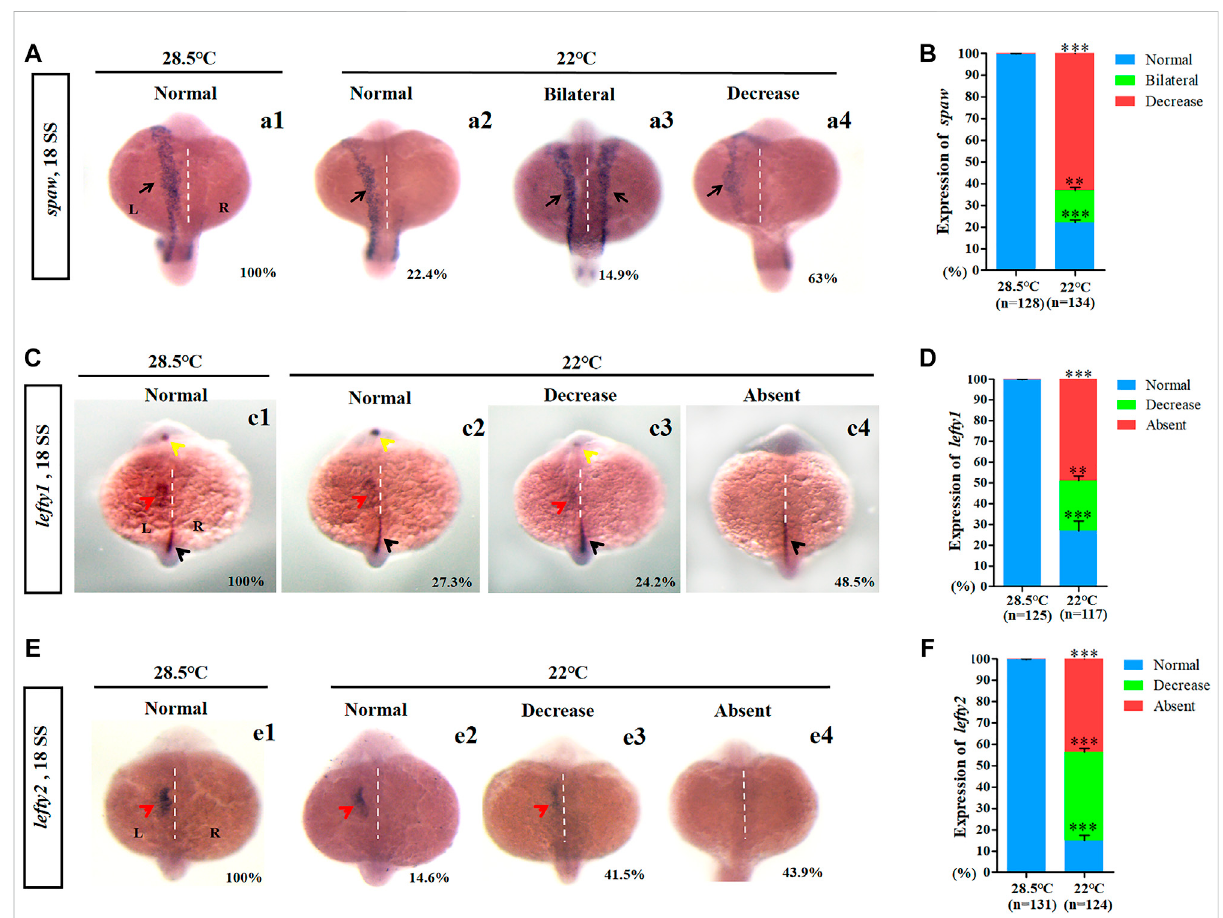
FIGURE 2 Expression of left-sided Nodal signaling in control and embryos treated with mild cold stress. (A,B) Expression of spaw . a1, left-side spaw at 28.5 ° C (100%, n = 128); a2, left-side spaw at 22 ° C (22.4%, n = 134, p < 0.001); a3, bilateral spaw at 22 ° C (14.9%, n = 134, p < 0.03); a4, decreased expressionof spaw at22 ° C(63%, n =134, p < 0.001). (C,D) Lefty1 isexpressedinthelefttelencephalon(yellowarrow),leftheart fi eld(redarrow),trunk midline, and tail midline (black arrow). c1, normal lefty1 at 28.5 ° C (100%, n = 125); c2, normal lefty1 at 22 ° C (27.3%, n = 117, p < 0.001); c3, decreased expression of lefty1 at 22 ° C (24.2%, n = 117, p < 0.01); c4, absent lefty1 at 22 ° C (48.5%, n = 117, p < 0.002). (E,F) Lefty2 is expressed in left heart fi eld (red arrow) at 18 SS. e1, normal lefty2 at 28.5 ° C (100%, n = 131); e2, normal lefty2 at 22 ° C (14.6%, n = 124, p < 0.001); e3, decreased expression of lefty2 at 22 ° C (41.5%, n = 124, p < 0.001); e4, absent lefty2 at 22 ° C (43.9%, n = 124, p < 0.001). “ ** “ p < 0.03; “ *** “ p <